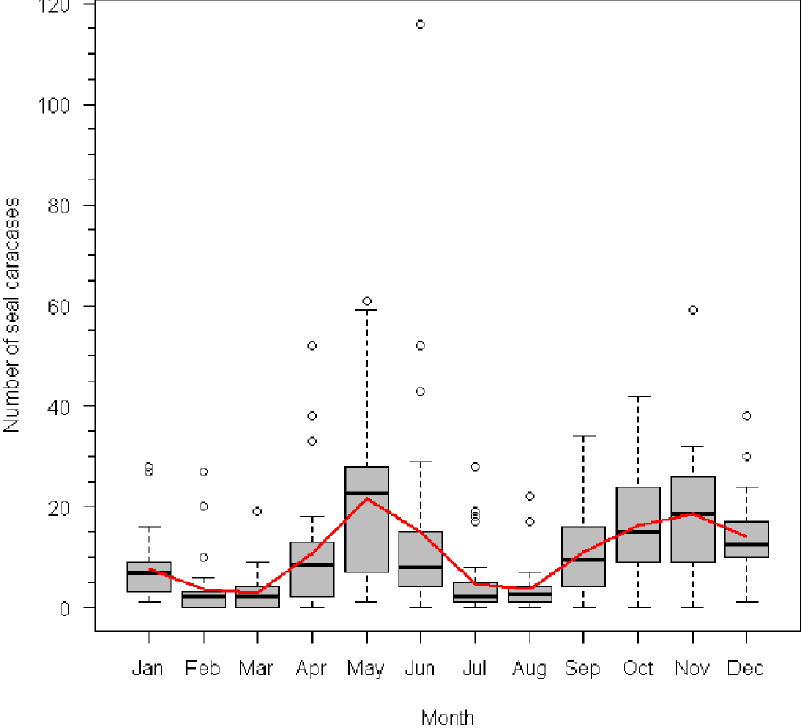
Figure 2. Boxplot for number of Caspian seal carcases recorded monthly (1971–2008) in the 10 km Apsheron monitoring zone. Central line of boxes gives median carcases per month. Red line gives mean carcase number.